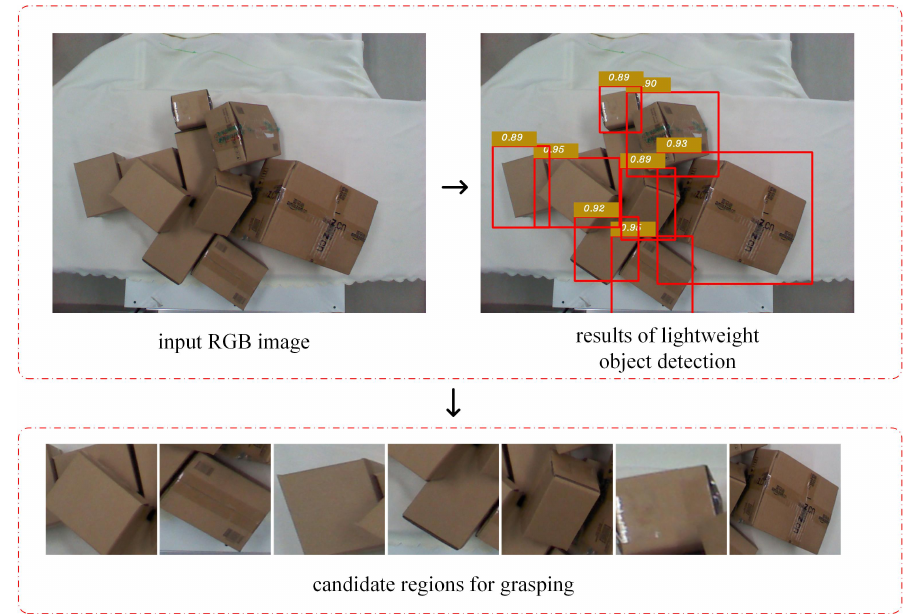
Figure 5. Candidate regions for grasping after lightweight object detection.